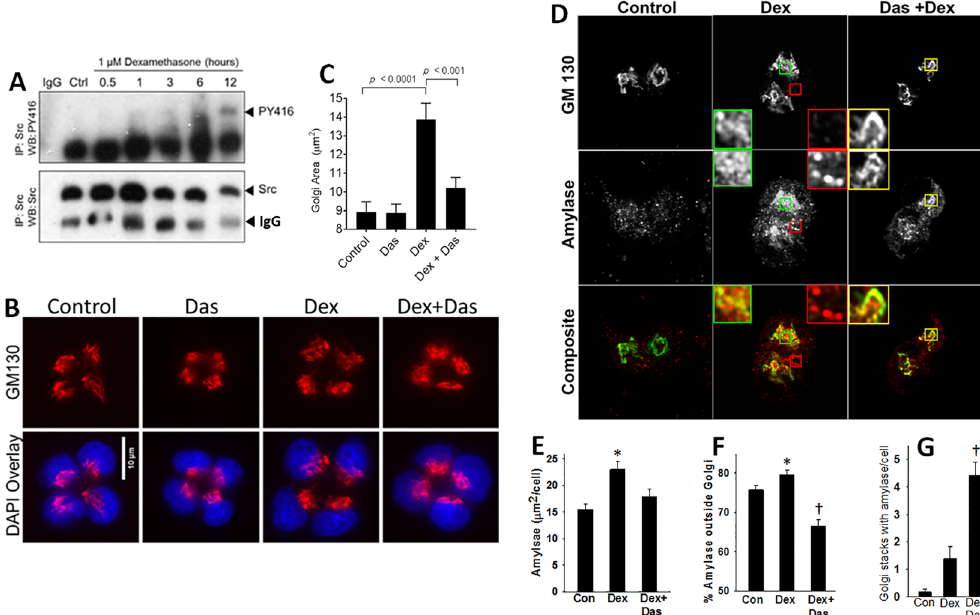
Figure 4. Effect of pharmacologic Src inhibition on dexamethasone (Dex) induced changes in AR42J cells. ( A ) Western blot of AR42J cell lysates collected after differ times of Dex (1 μ M) stimulation immunoprecipitated for total Src and blotted for active Src (PY416; upper panel) and total Src (middle panel). ( B ) Immunofluorescent images of AR42J cells after one day stimulation with Dex stimulation stained for GM130(upper panel) with DAPI overlay (Lower panel). ( C ) Bar graph of Golgi area of AR42J cells after different treatments. ( D ) Immunofluorescent images of AR42J cells after 1 day of Dex alone or with Dasatinib (Das) stained for GM 130 (upper panel), amylase (middle panel) and composite images lower panel. Bar graphs quantifying the total stained amylase area ( E ) % amylase outside the Golgi area ( F ) and number of stacks positive for amylase in each cell ( G ). * Indicates a significant increase vs. control and † a significant (p < 0.05) change from Dex induced by